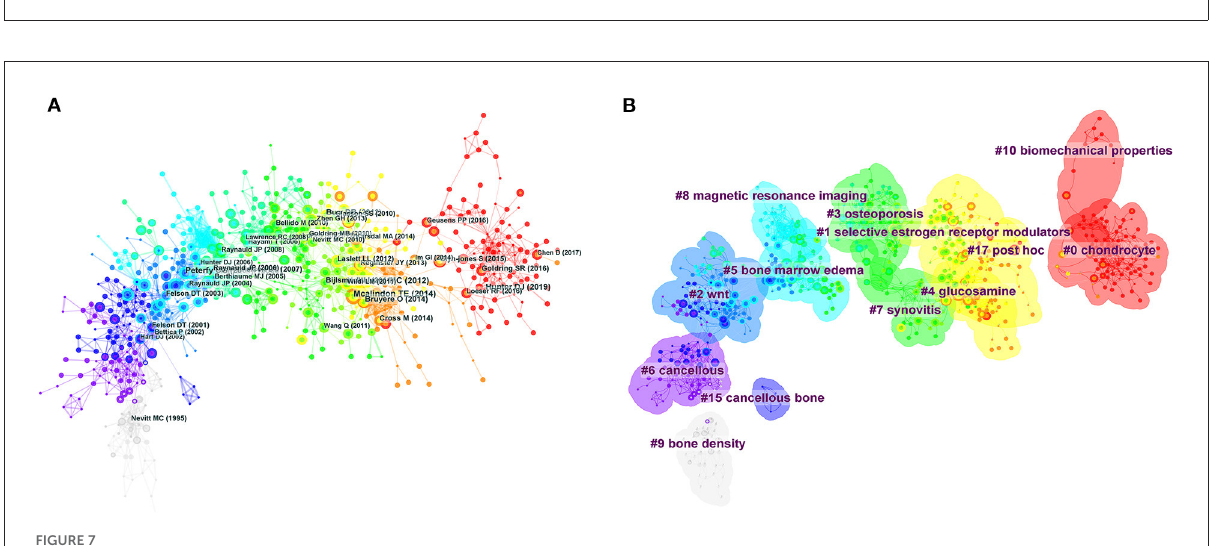
space is closely related to tibial subchondral bone mineral density (BMD). The larger the tibial subchondral bone mineral density, the smaller the width of medial knee joint space,